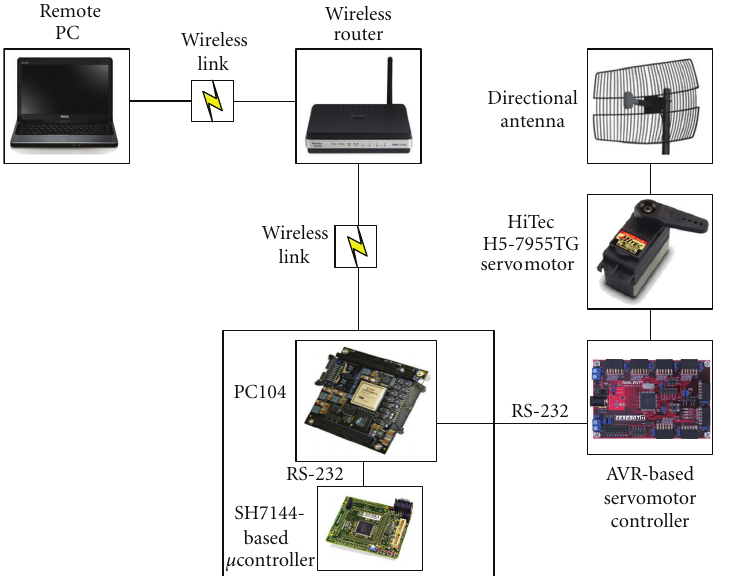
Figure 3: A block diagram of the hardware architecture of one of the robots.